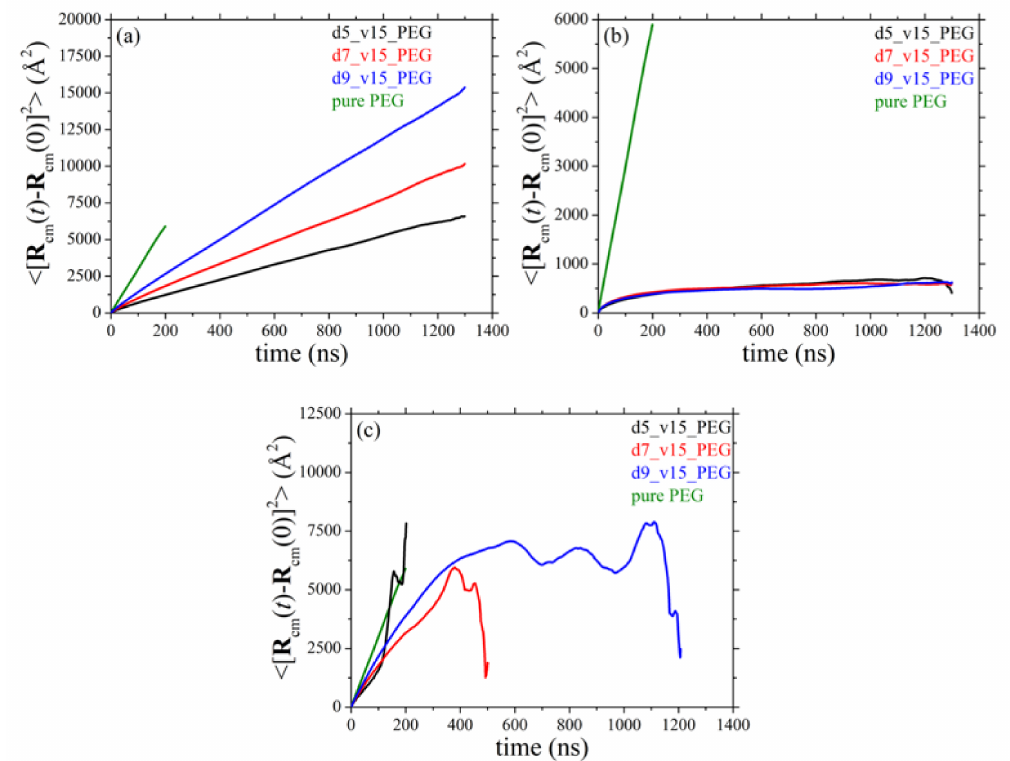
Figure 12. Mean-square displacement of the chains centers-of-mass as a function of time for: ( a ) all PEG chains, ( b ) only adsorbed PEG chains, and ( c ) only free PEG chains ( T = 413 K and p = 1 atm) in systems 1–4 (dependence on silica size).